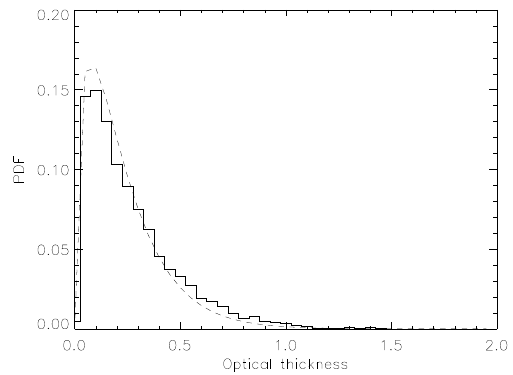
Figure 7. Probability density function of the optical thickness of the tracked contrails. The dashed line represents the probability density function of the gamma distribution (see